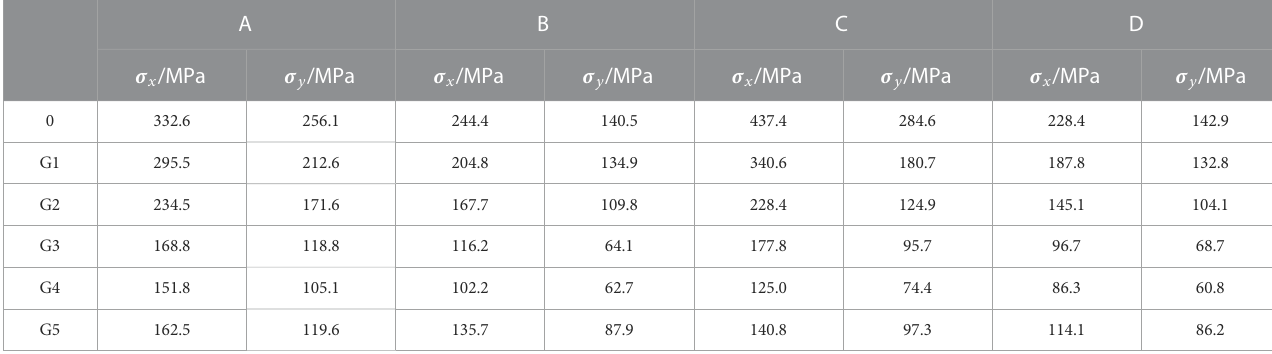
TABLE 3 Residual stress under different ultrasonic powers.